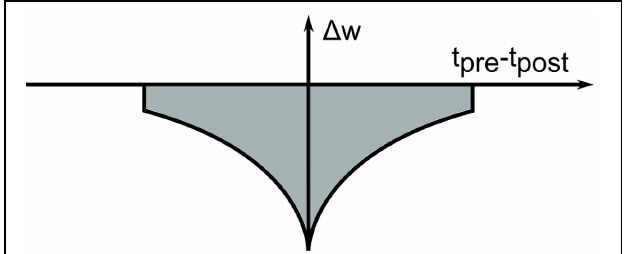
FIGURE 3 | Short-term plasticity kernel for Generation mode. The “fast-weight” STDP kernel temporarily depresses all synapses in which the pre- and post-synaptic neurons were active shortly after each other, depending on the spike timing difference t pre − t post . As a result, the network is constantly being pushed out of its present state.